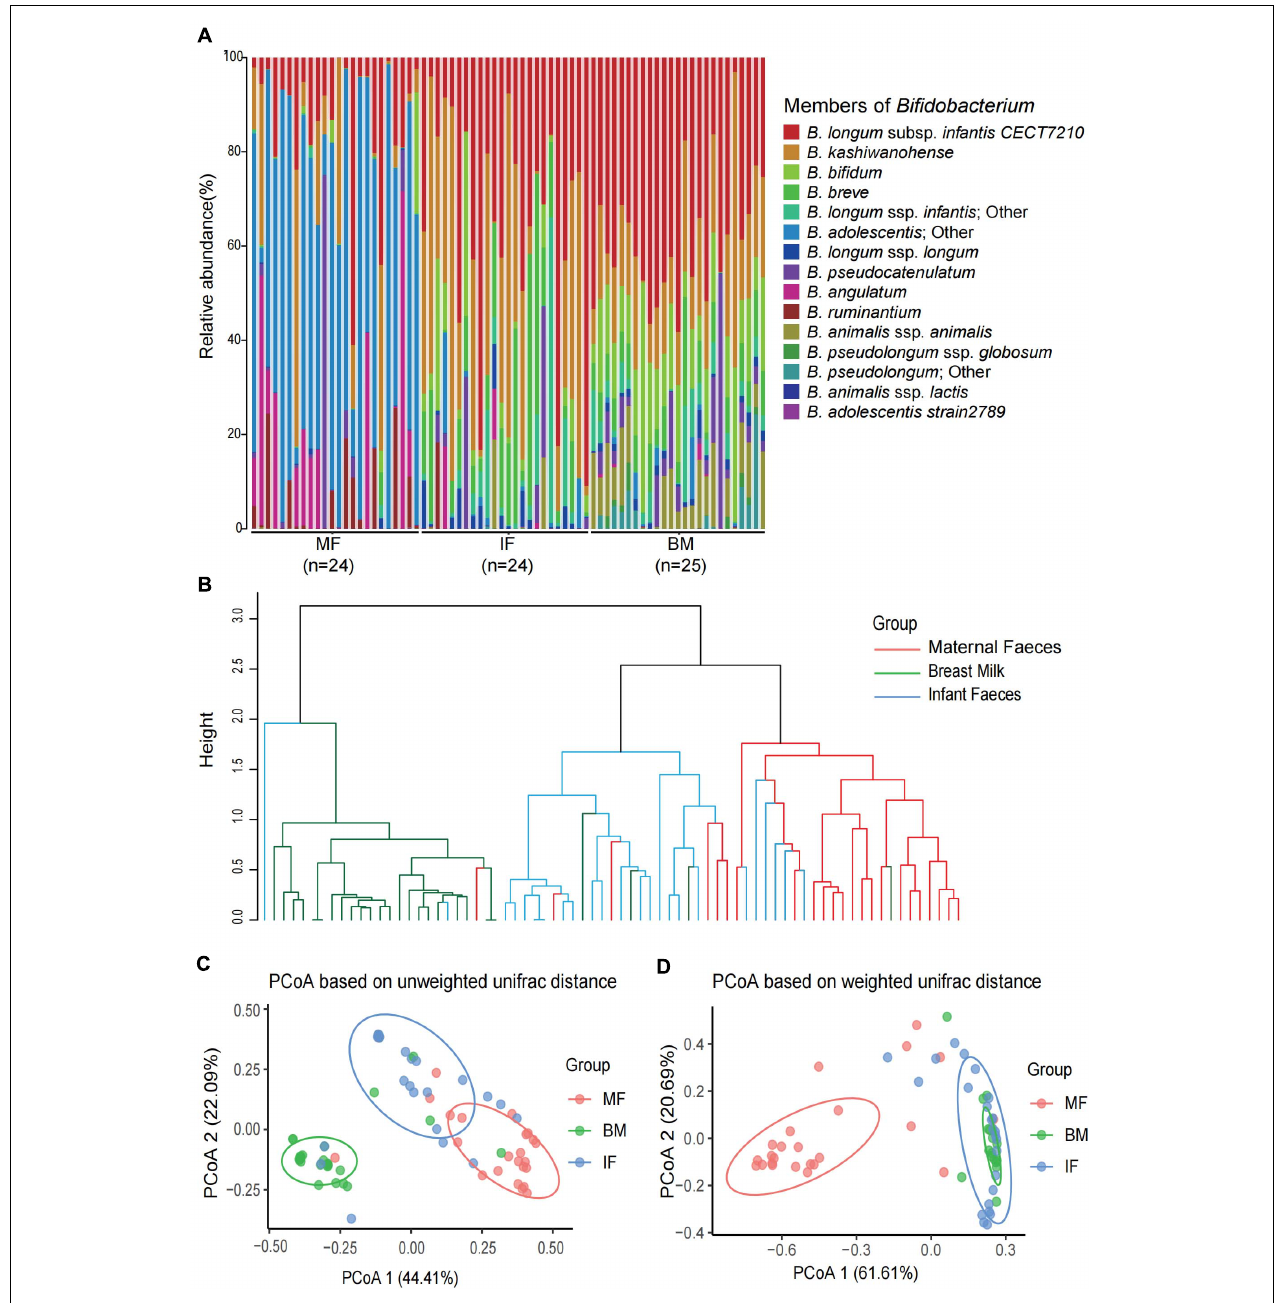
FIGURE 4 | The composition and diversity of Bifidobacterium phylotypes in each infant feces, maternal feces, and breast milk samples. (A) The composition of Bifidobacterium phylotypes in each infant feces, maternal feces, and breast milk samples. (B) The hierarchical clustering based on unweighted UniFrac distance among the three ecosystems samples. Principal coordinate analysis based on unweighted UniFrac distances (C) and weighted UniFrac distances (D) among the three ecosystems. Ellipses represent a 95% confidence interval around the cluster centroid. In both PCoAs, first and second principal components (PCoA1 and PCoA2) were plotted. The significant difference of each two groups in panels (C,D) was evaluated by permutational multivariate analysis of variance. All p -values of each two groups are less than